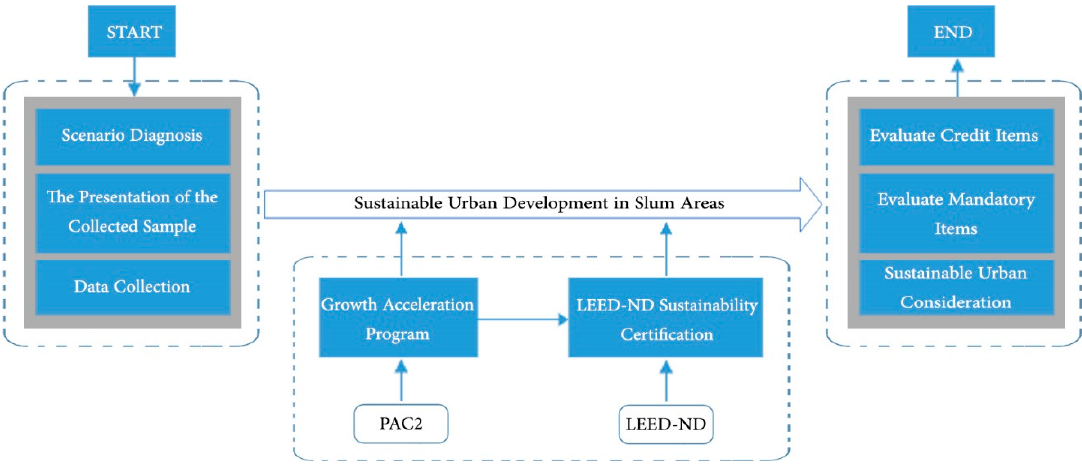
Figure 1. Proposed research method.